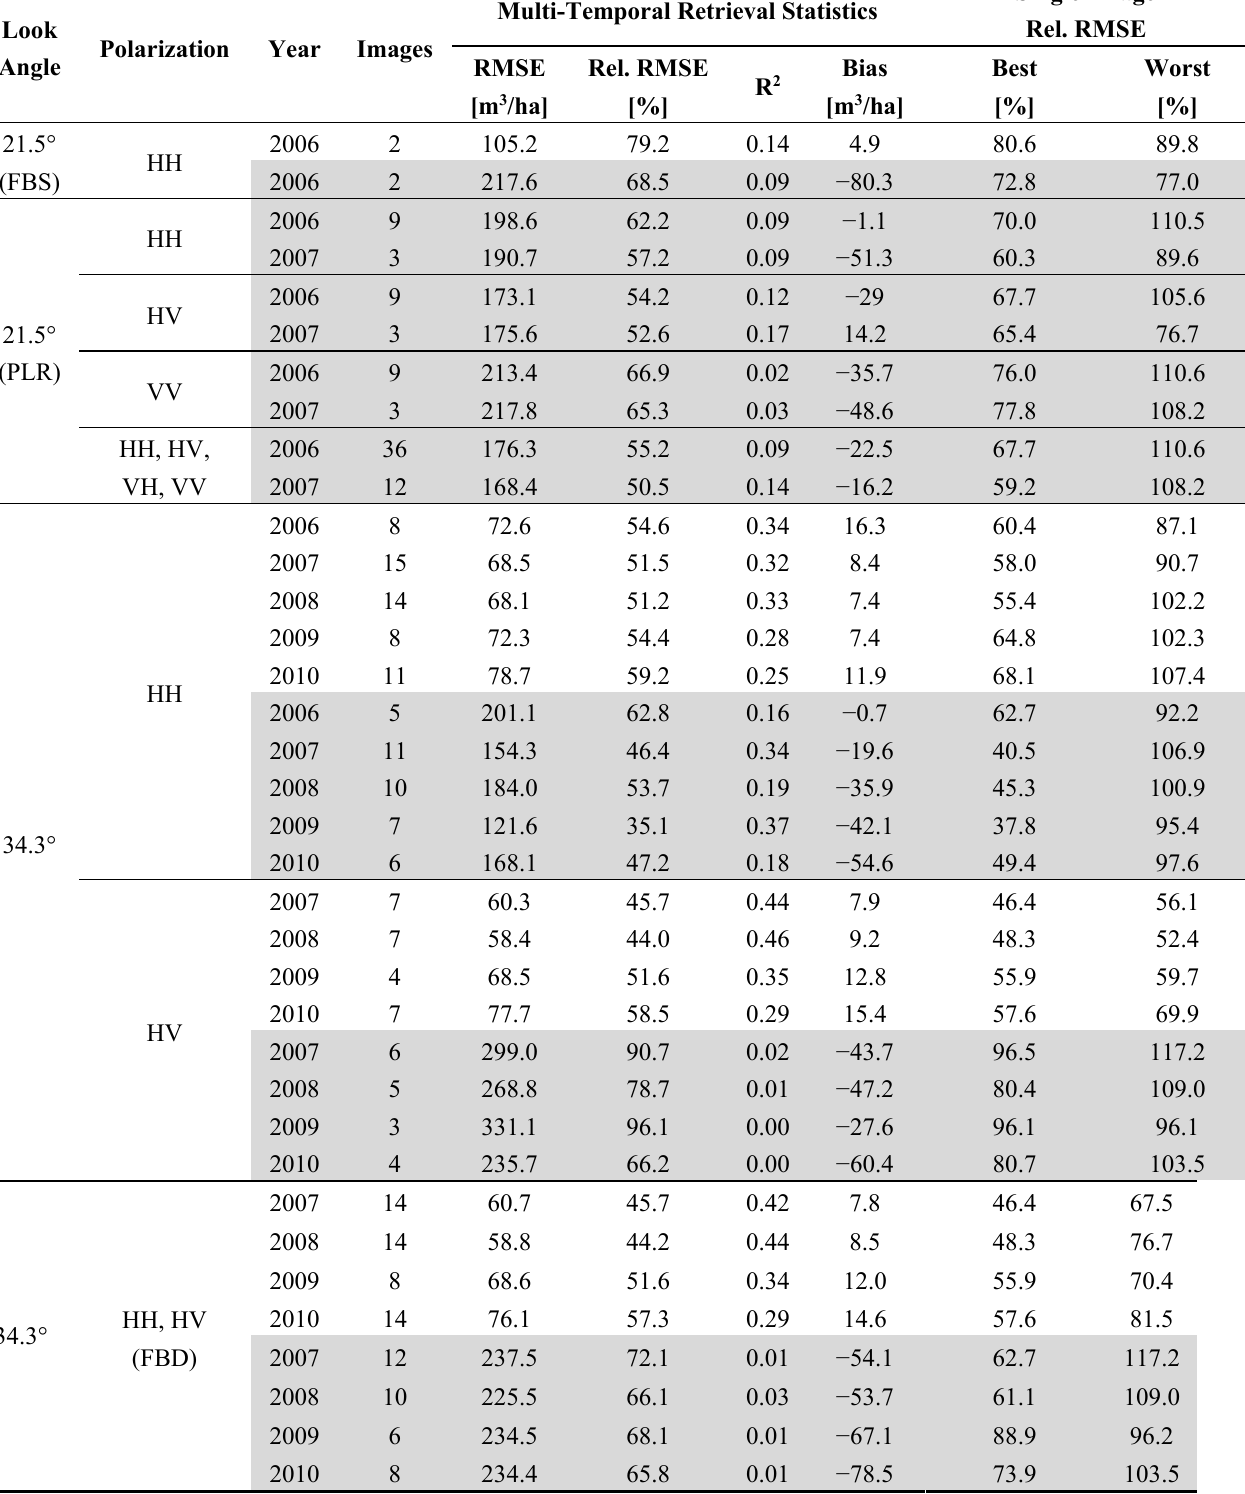
Table 6. Retrieval statistics for multi-temporal combinations available in the PALSAR datasets. For each combination, the best and worst retrieval statistics for a single-image retrieval are also reported. Transparent cells refer to Krycklan and shaded cells to Remningstorp.